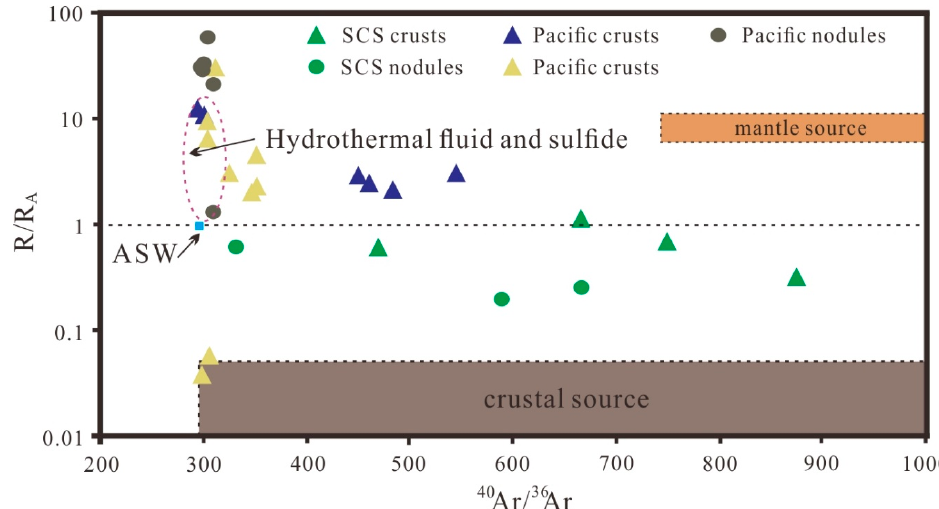
Figure 3. 40 Ar/ 36 Ar vs. R/R A diagram of the SCS Fe-Mn crusts and nodules (revised after Burnard et al. [73]; green triangles and circles of SCS crusts and nodules data from this study; grey circles of Pacific nodules data from [33]; yellow and blue triangles of Pacific crusts data from [47,48], respectively). Furthermore, 4 He concentrations of the nodules are much higher than those of the crusts (Table 2).